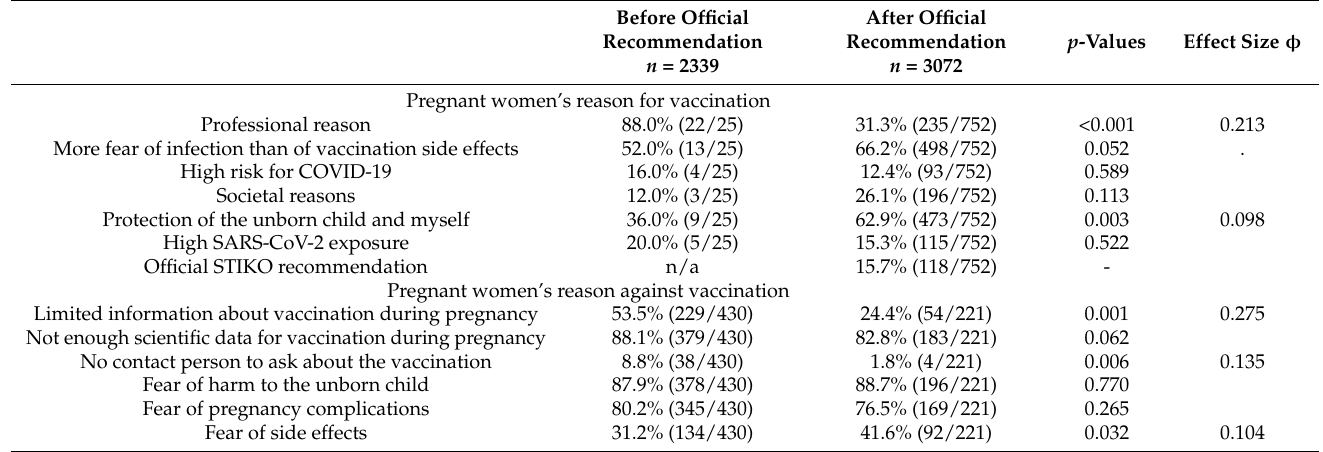
Table 2. Comparison of reasons for and against COVID-19 vaccination in pregnancy in relation to the publication of the STIKO